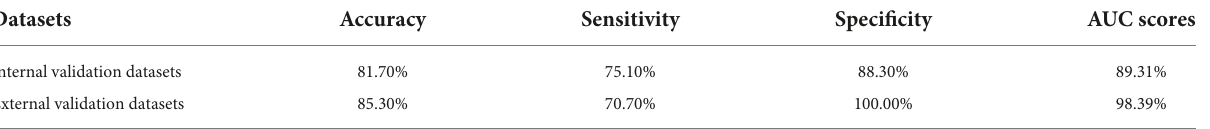
TABLE 2 Accuracy, sensitivity, specificity, AUC scores of internal and external